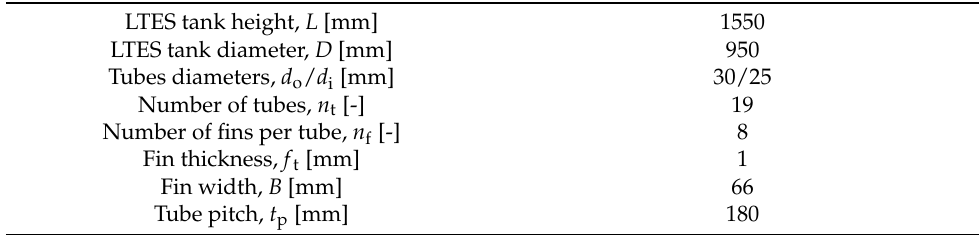
Table 2. Thermo-physical properties of PCM paraffin RT25, water and aluminum used in numeri- cal